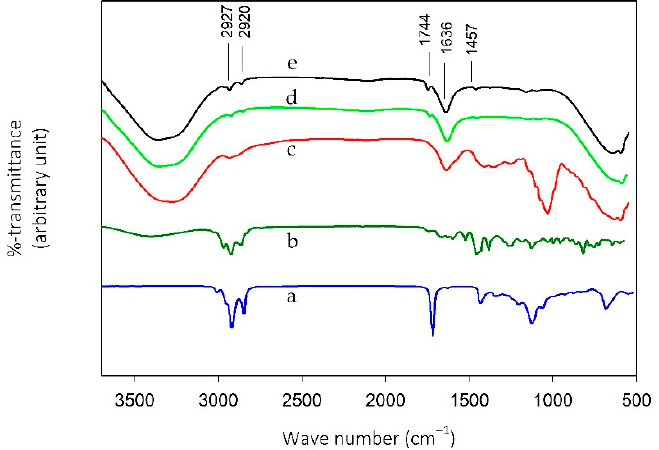
Figure 2. FTIR spectra of corn oil ( a ), temulawak extract ( b ), red dragon fruit extract ( c ), emulsion #13 ( d ), and emulsion #8 ( e